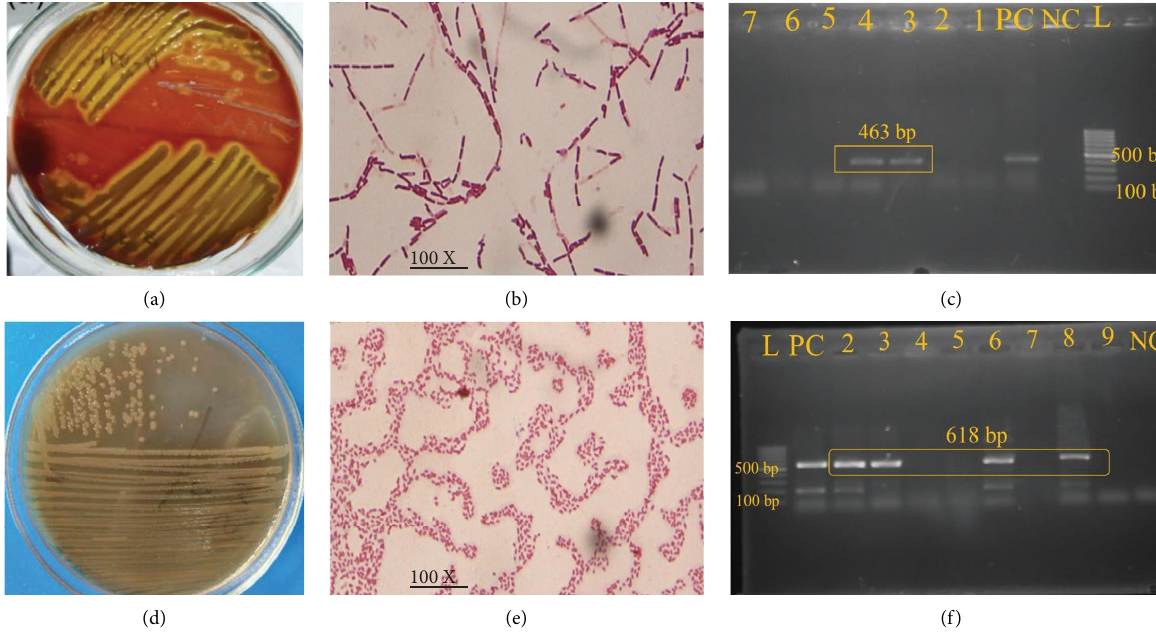
Figure 7: Isolation and identifcation of (a), (b), and (c) morphological, Gram’s staining, and molecular detection of Bacillus spp. and (d), (e), and (f) morphological, Gram’s staining, and molecular detection of Pseudomonas spp.